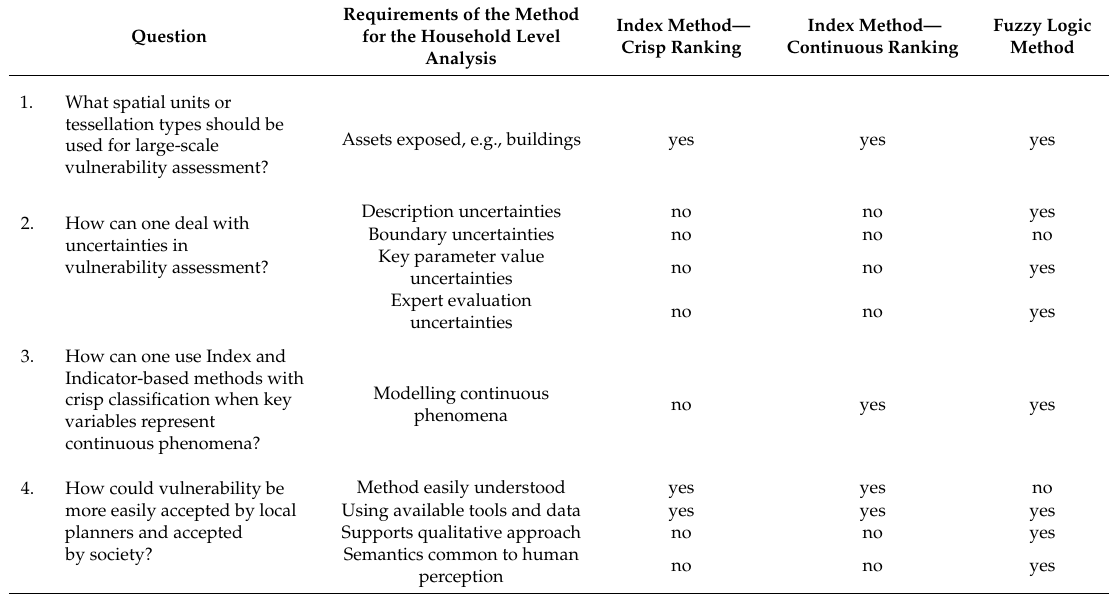
Table 6. A comparison of the methods satisfying the requirements for the household level analysis. Requirements of the Method Question for the Household